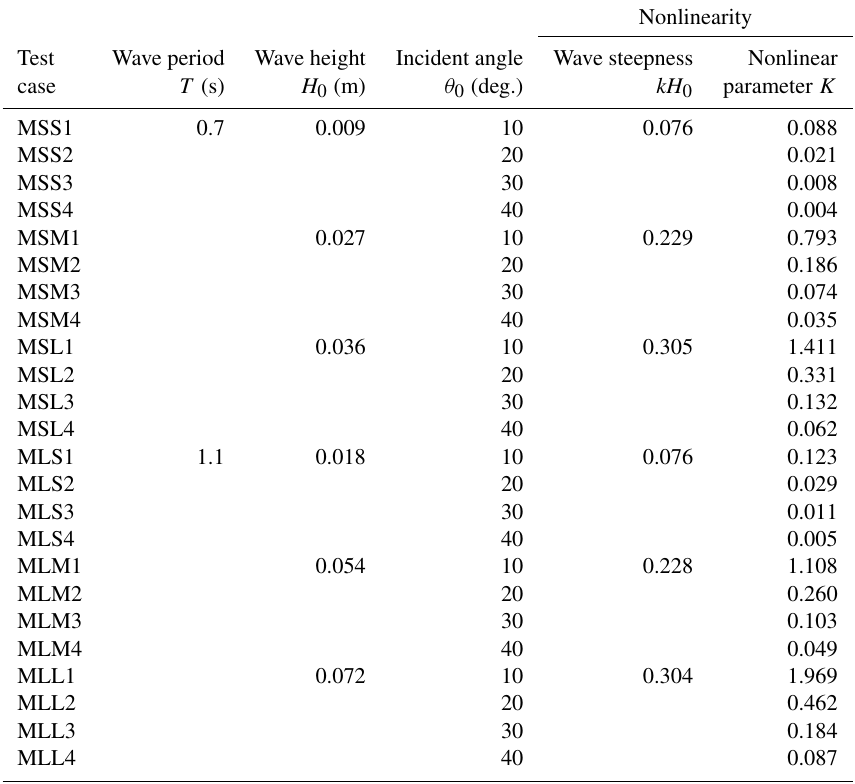
Table 1. Experimental wave conditions ( h = 0.25m).